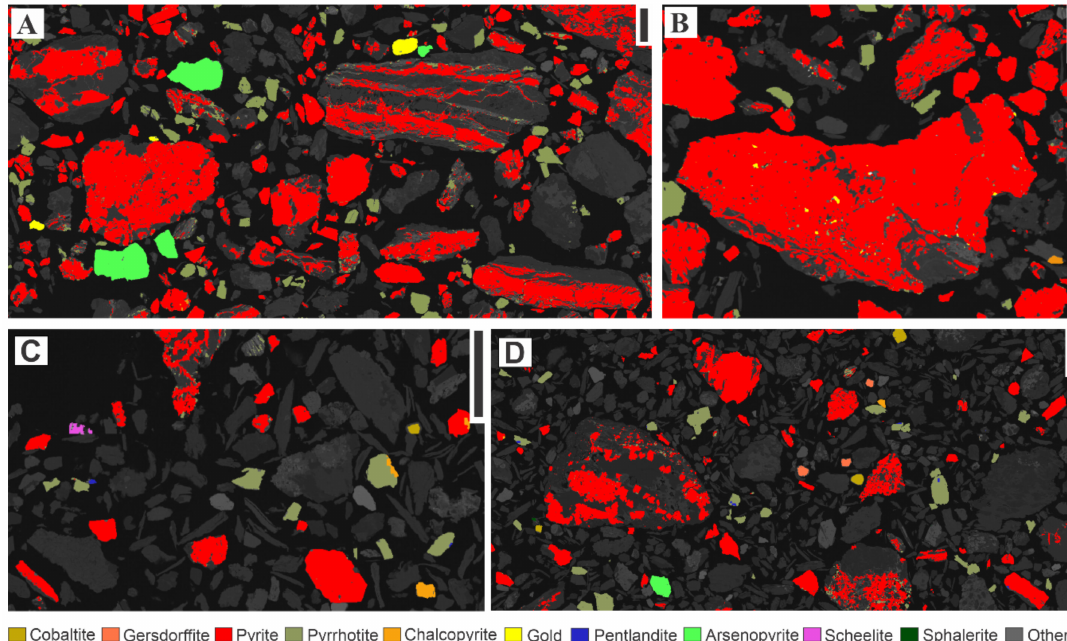
Figure 7. TIMA mineral map showing gold and sulfides in the mineralization. ( A ) Gold occurs mainly as free grains with pyrite, pyrrhotite, arsenopyrite, and with hydrothermal mineral association shown in Figures 8 and 9A,B. ( B ) Gold occurs as inclusions in pyrite. ( C , D ) the mineralization contains pyrite, pyrrhotite, pentlandite, scheelite, arsenopyrite, chalcopyrite, cobaltite, and gersdorffite. The vertical scale bars in all images are 250 µ